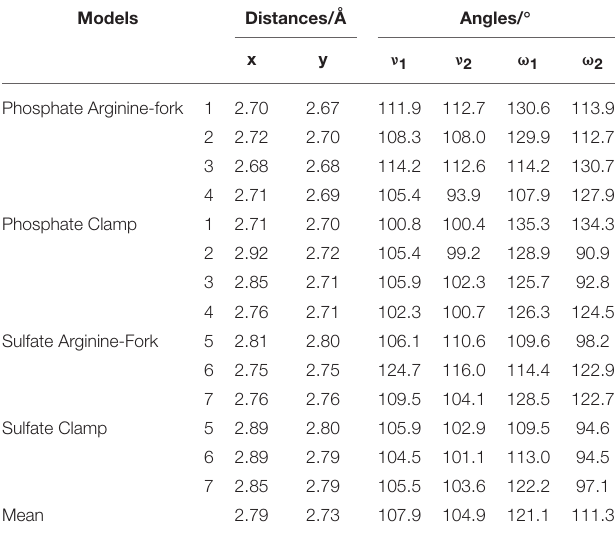
TABLE 3 | Distances (in Ångström) and bond angles (in degree) involved in the formation of clamps and arginine-forks. Models Distances/Å Angles/